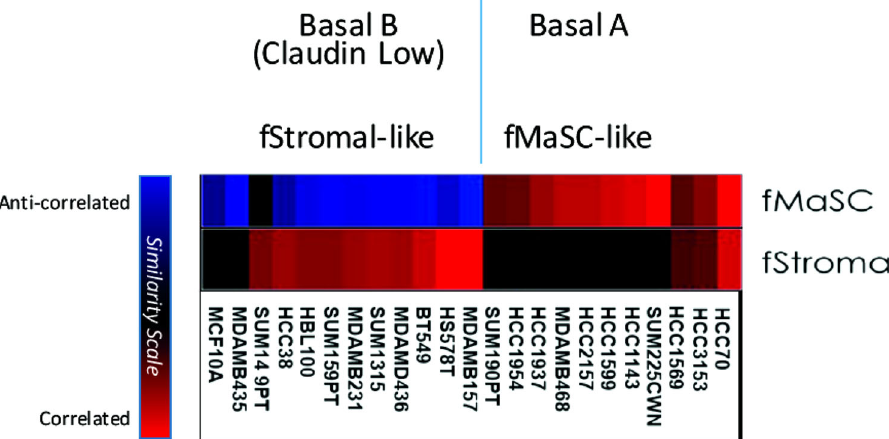
Fig. 2 Breast cancer cell lines show differential enrichment for fetal epithelial signatures (fMaSC) and fetal non-epithelial signatures (fStromal). Basal A Cell Lines, which are most similar to ‘ Basal-like ’ breast cancers, show enrichment for fMaSC signatures. Basal B cell lines, which have a more mesenchymal phenotype, exhibit classic BCSC markers and correspond to ‘ Claudin Low ’ tumors. Claudin low tumors are enriched for non-epithelial signatures and are anti-correlated to the fMaSC state. The SUM149PT cell line shows enrichment for non-epithelial signatures similar to other cell lines classi fi ed as Basal B in the Neve et al. data set, but shows less repression of the epithelial fMASC signature. 149 This observation, and this cell line ’ s subsequent characterization as Basal-like as opposed to Claudin Low, may be attributable to an intermediate or heterogeneous phenotype among its constituent cells. 150 Claudin low cell lines also show signi fi cant enrichment for the aMaSC signature (not shown). Assessment of signature enrichment was based on signatures from Spike et al. 107 and methods described in Segal et al.